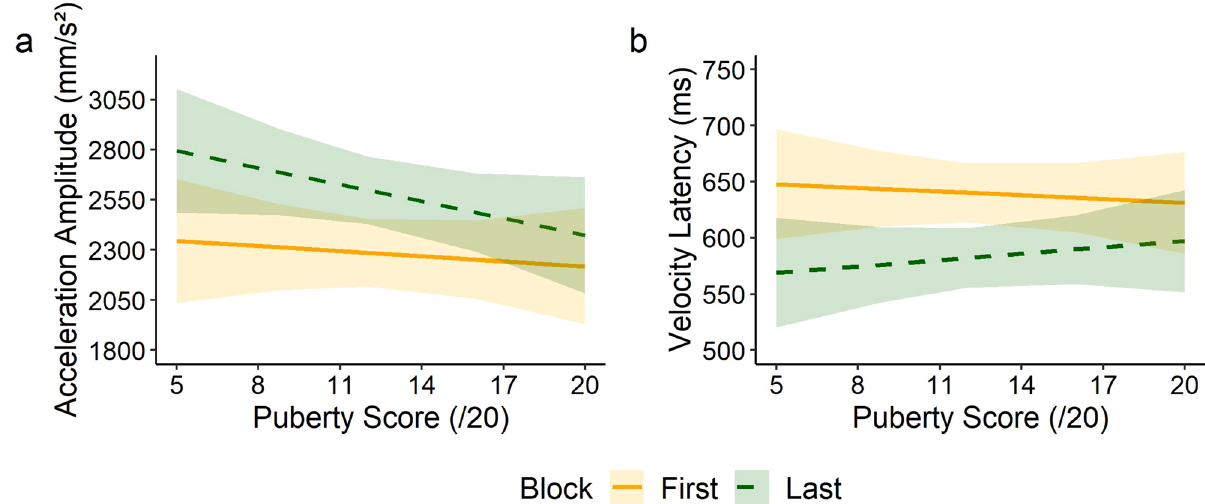
Figure 5. Evolution of the kinematics of the Reaching component of the movement during the first (solid orange) and the last (dashed green) blocks of tool use, as a function of the puberty score. Panels a and b are representative illustrations of the polynomial fit of the data for the acceleration amplitude ( a ) and the velocity latency ( b ), with the 95% confidence interval indicated by colored areas. Most significant interactions indicated that improvement through tool use is less important in late